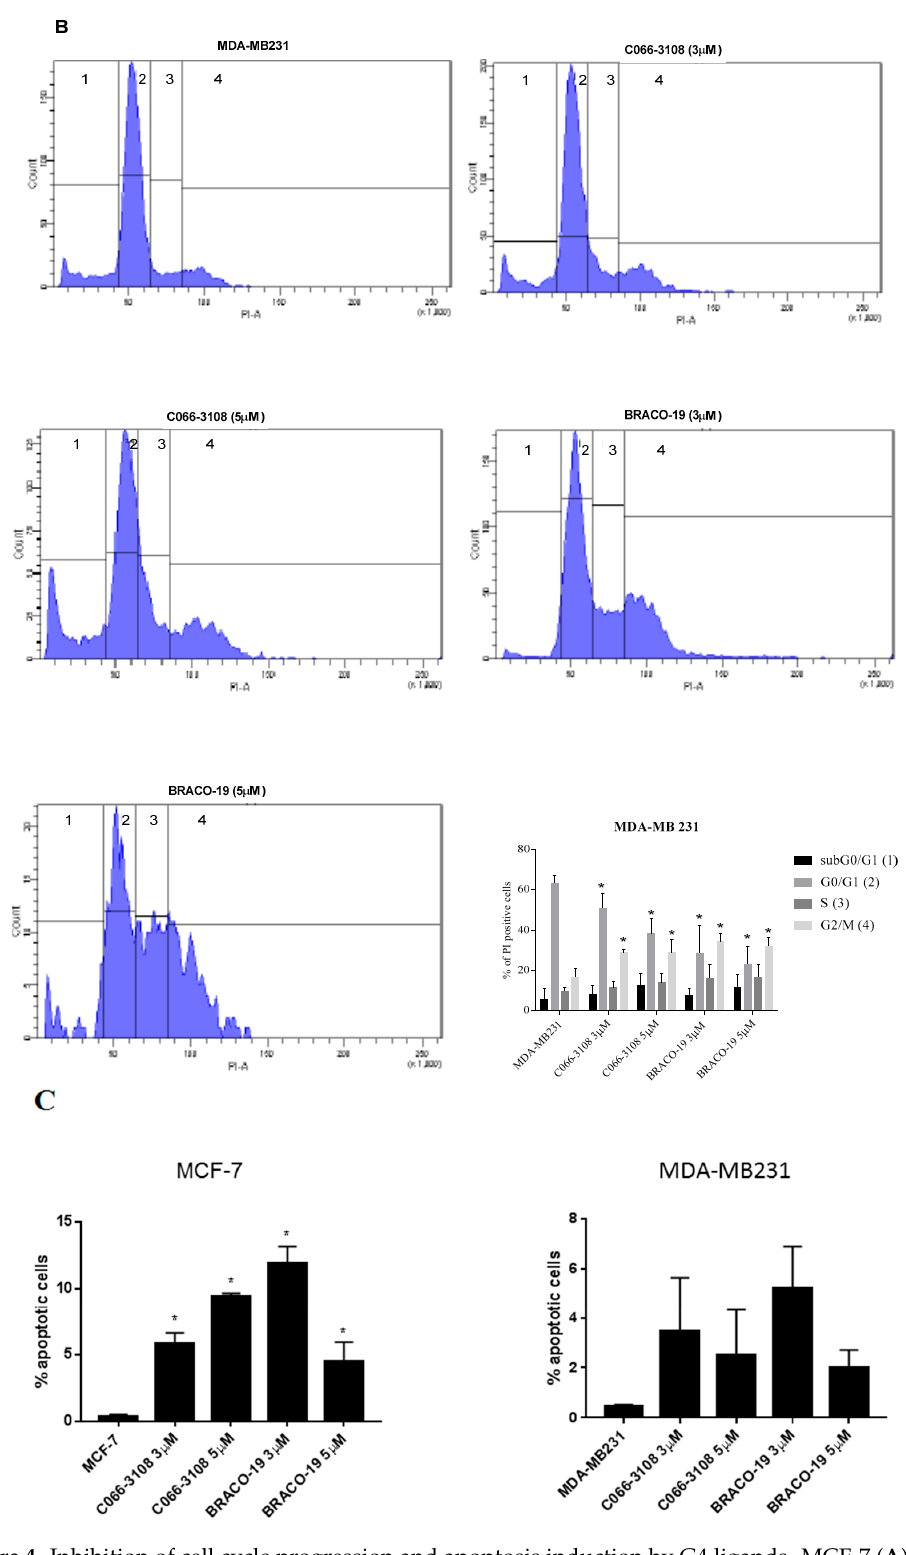
Figure 4. Inhibition of cell cycle progression and apoptosis induction by G4 ligands. MCF-7 ( A ) and MDA-MB231 ( B ) cells were treated with G4 ligands at the indicated concentrations. Cells were stained with PI to evaluate cell cycle progression. A representative flow cytometry profile of cell cycle is shown for both cell lines, and the percent of cells in each phase of the cell cycle is indicated for the single experiment, whereas the bars in the histograms represent the mean ± SD of at least three